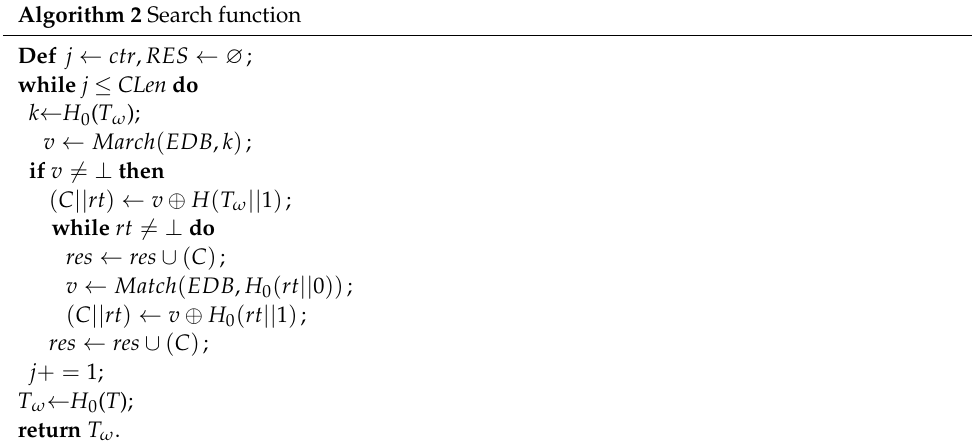
Algorithm 2 Search function